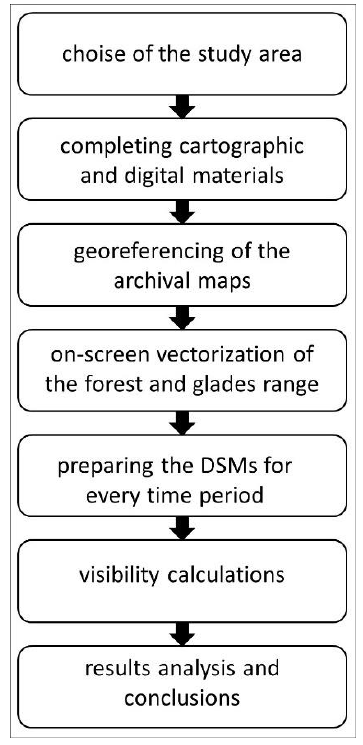
Figure 2. Schematic diagram of the research procedure.